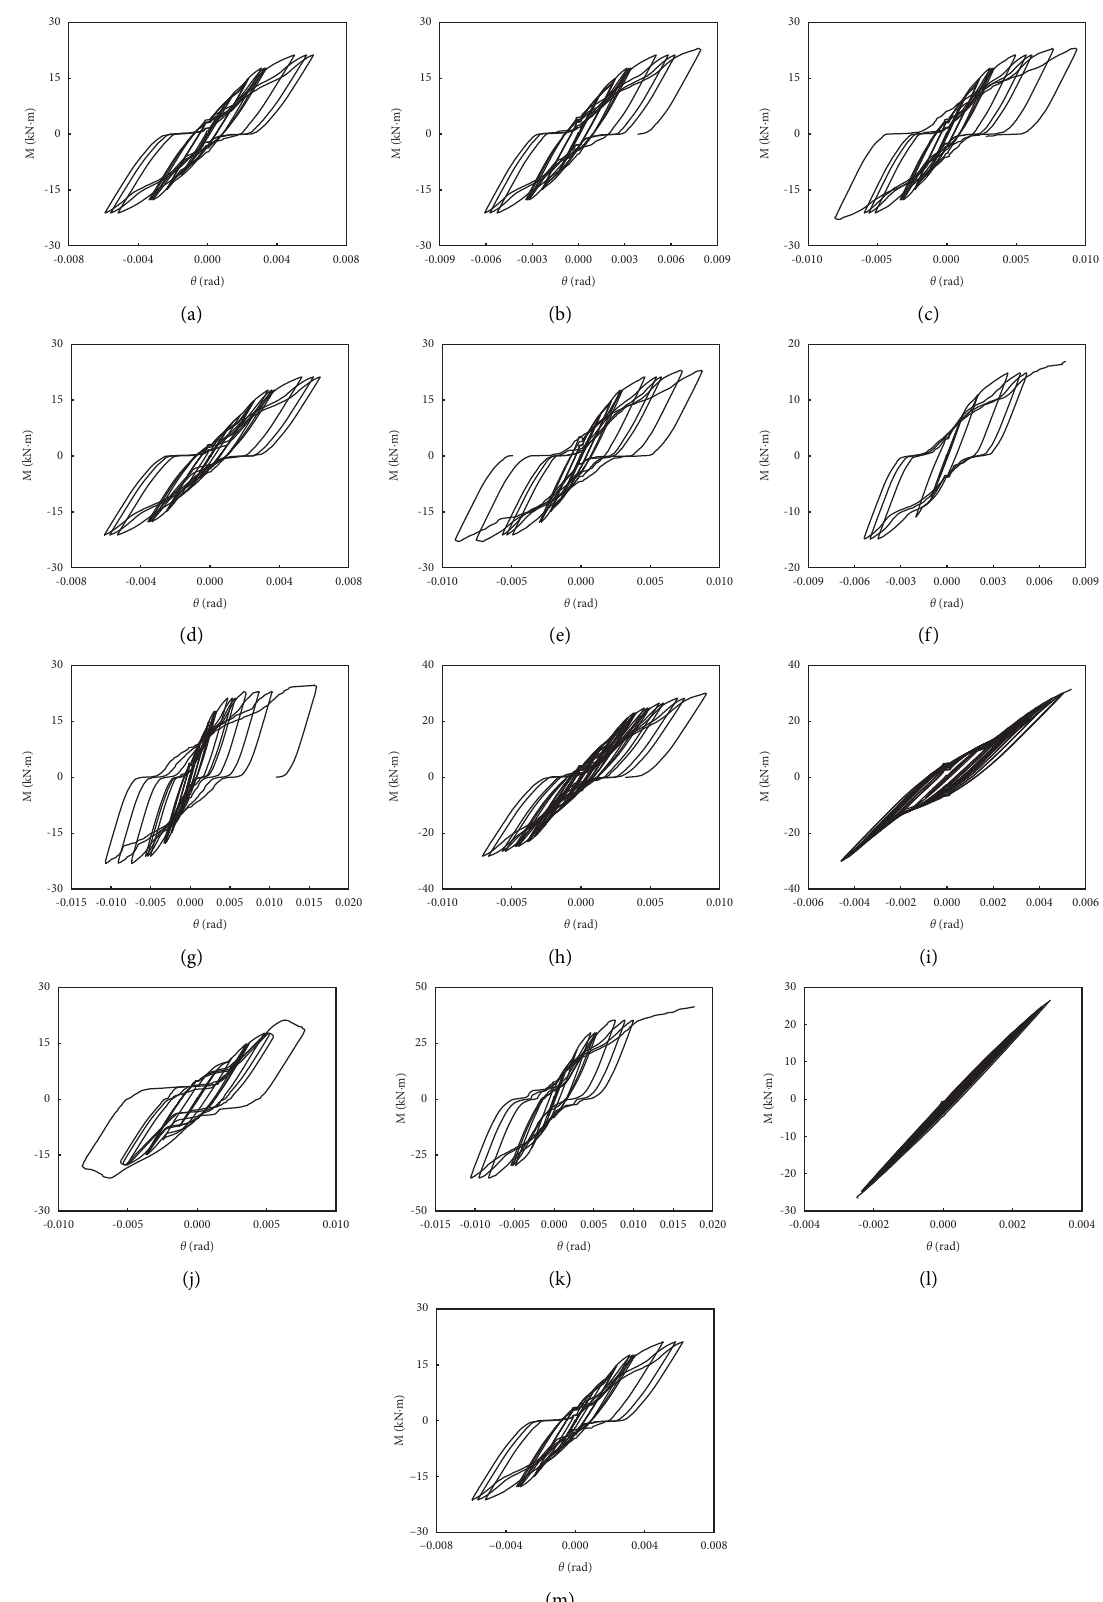
Figure 4: Moment-rotation hysteretic curve. (a) Case 1. (b) Case 2. (c) Case 3. (d) Case 4. (e) Case 5. (f) Case 6. (g) Case 7. (h) Case 8. (i) Case 9. (j) Case 10. (k) Case 11. (l) Case 12. (m) Case